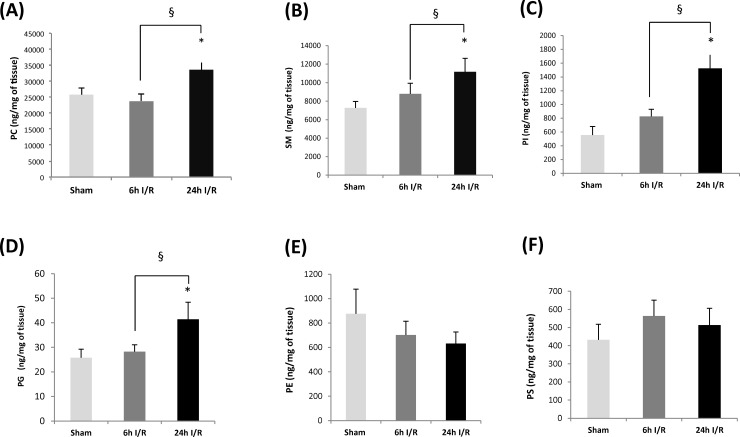
Representative amounts of non-oxidized lipids in renal tissue from sham, 6h and 24h I/R groups.Average (A) PC, (B) SM, (C) PI, (D) PG, (E) PE and (F) PS concentrations in rat renal tissue in sham and 6 and 24h I/R groups (n = 4 in each group). * Significant difference compared to sham, P< 0.05. § Significant difference between I/R groups, P<0.05. Abbreviations: PC: Phosphatidylcholine, SM: Sphingomyelin, PI: Phosphatidylinositol, PG: Phosphatidylglycerol, PE: Phosphatidylethanolamine, PS: Phosphatidylserine.